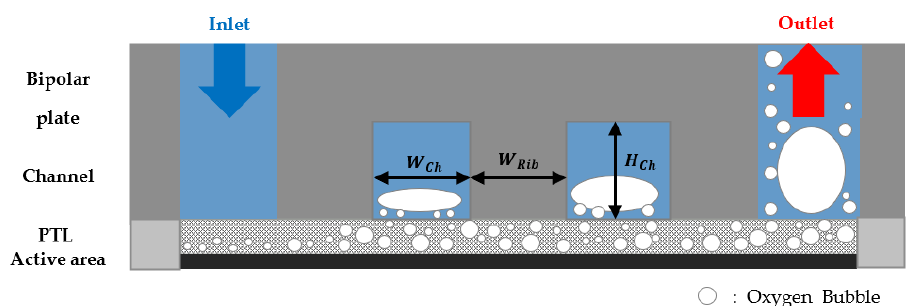
Figure 2. Schematic of ( a ) the computational fluid domain and ( b ) channel and PTL flow fields in the anode side of PEMWE.